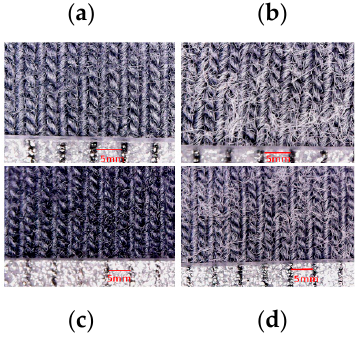
Figure 7. Surface morphology of pure cotton electrodes: ( a ) before washing: 7.4 wt.% PEDOT:PSS; ( b ) after 50 washes: 7.4 wt.% PEDOT:PSS; ( c ) before washing: 12.8 wt.% PEDOT:PSS; ( d ) after 50 washes: 12.8 wt.% PEDOT:PSS.